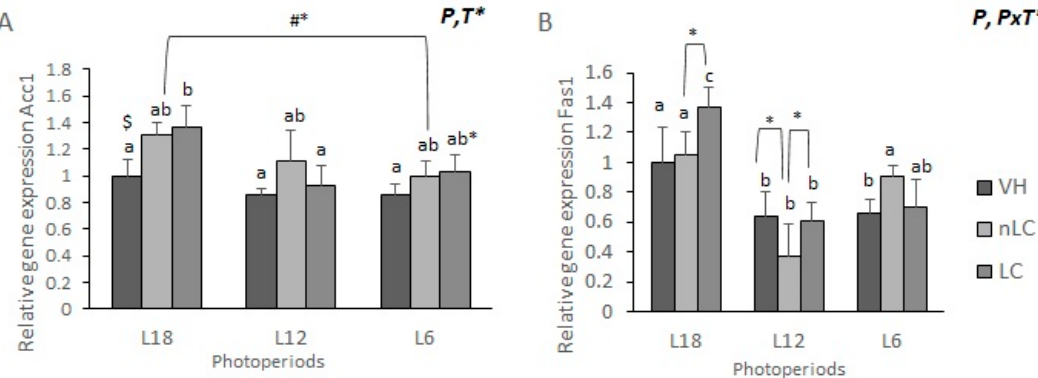
Figure 1. Gene expression of liver lipogenic enzymes. The mRNA levels of Acetyl-coenzyme A carboxylase (Acc1) ( A ) and fatty acid synthase (Fas1) ( B ) of male Fischer 344 rats treated for 7 weeks with vehicle (VH), non-Local cherries (nLC) or Local (LC), and exposed to different photoperiods (short; L6, standard; L12 or long; L18). Values expressed as mean ± SEM ( n = 8). The values were normalized by the L18-VH group. P, photoperiod effect; T, treatment effect; P x T, photoperiod effect and treatment. (two-way ANOVA, p < 0.05). Different letters above the bars indicate significant differences ( p < 0.05) (post-hoc DMS, one-way ANOVA). $ significant effect of treatment in the same photoperiod (Student’s t -test). * indicate trend (0.05 < p < 0.1). # * indicates trend (0.05 > p > 0.1) with Student's